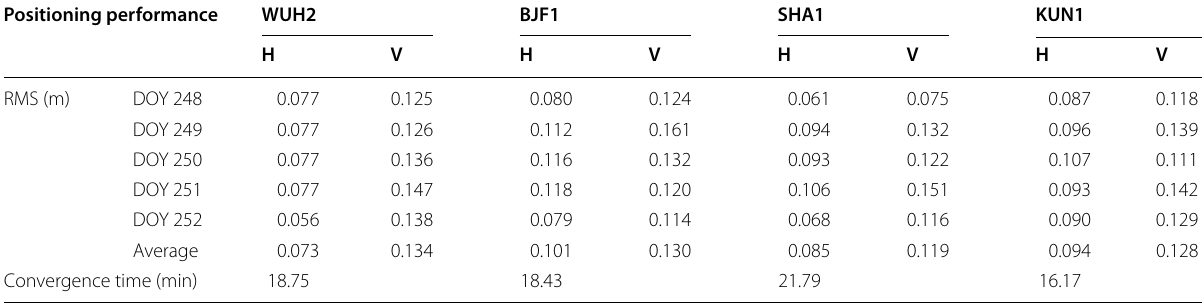
Table 4 Accuracy (root mean squares) and convergence time of BDS PPP-B2b kinematic positioning Positioning